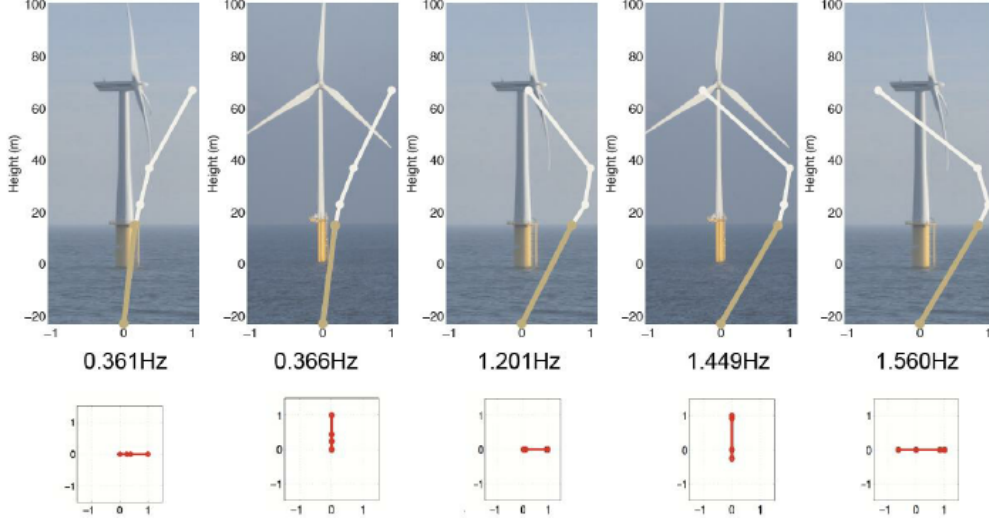
Figure 4. Dominant modes of an OWT. The fore–aft and side–side bending pairs are significantly close to each other (El-Kafafy et al.,